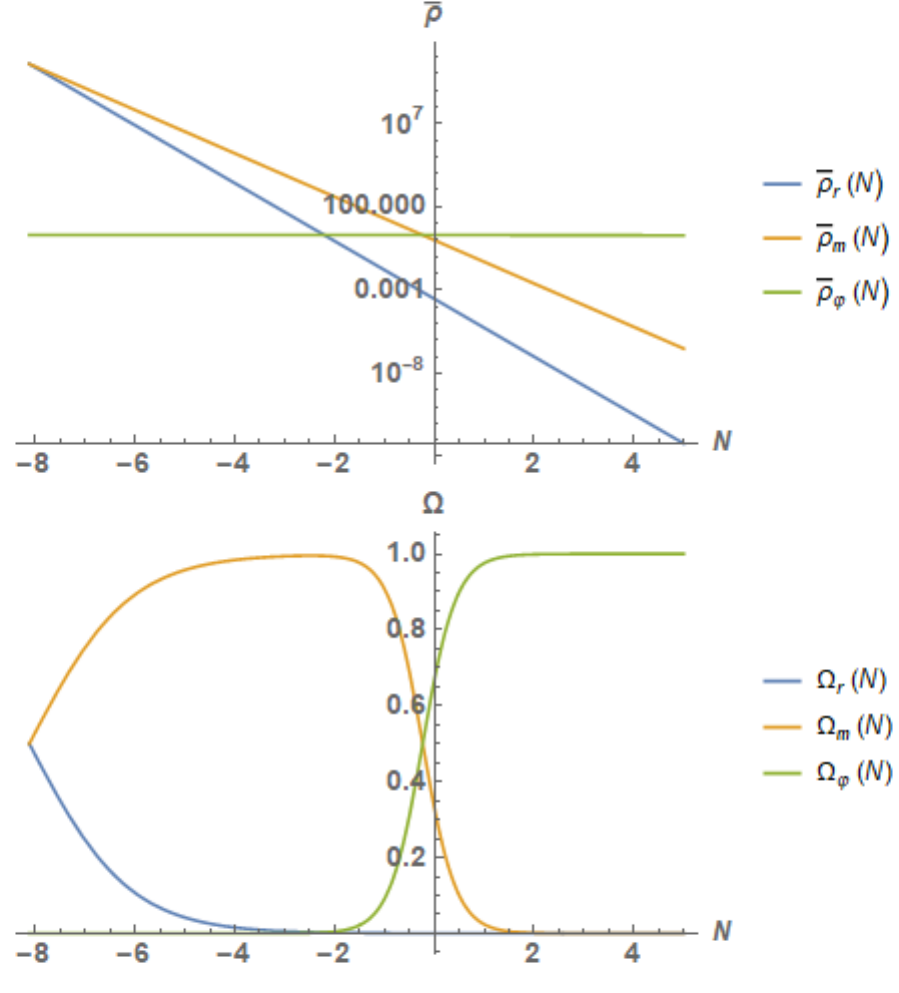
Figure 2. Evolution of { ¯ ρ B ( N ) } B = r , m , ϕ and { Ω B ( N ) } B = r , m , ϕ